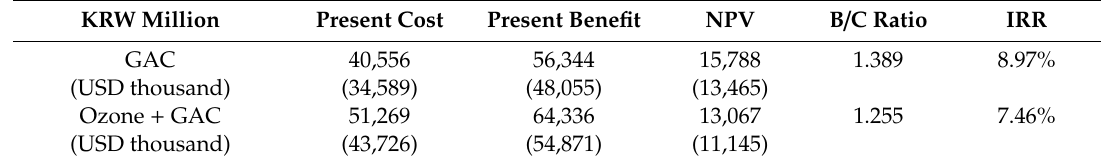
Table 12. Cost-benefit analysis of the two